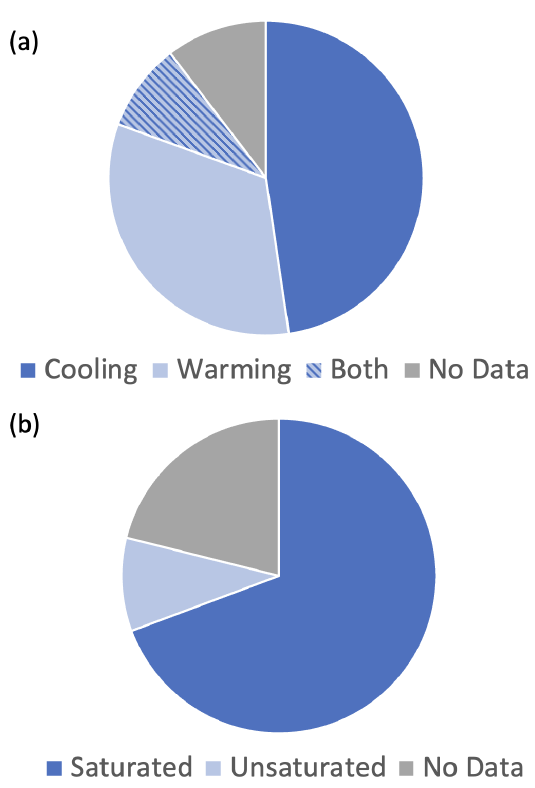
Figure 3. (a) Freezing (cooling) or thawing (warming) limb preva- lence in SFCC data as well as (b) the initial water content preva-